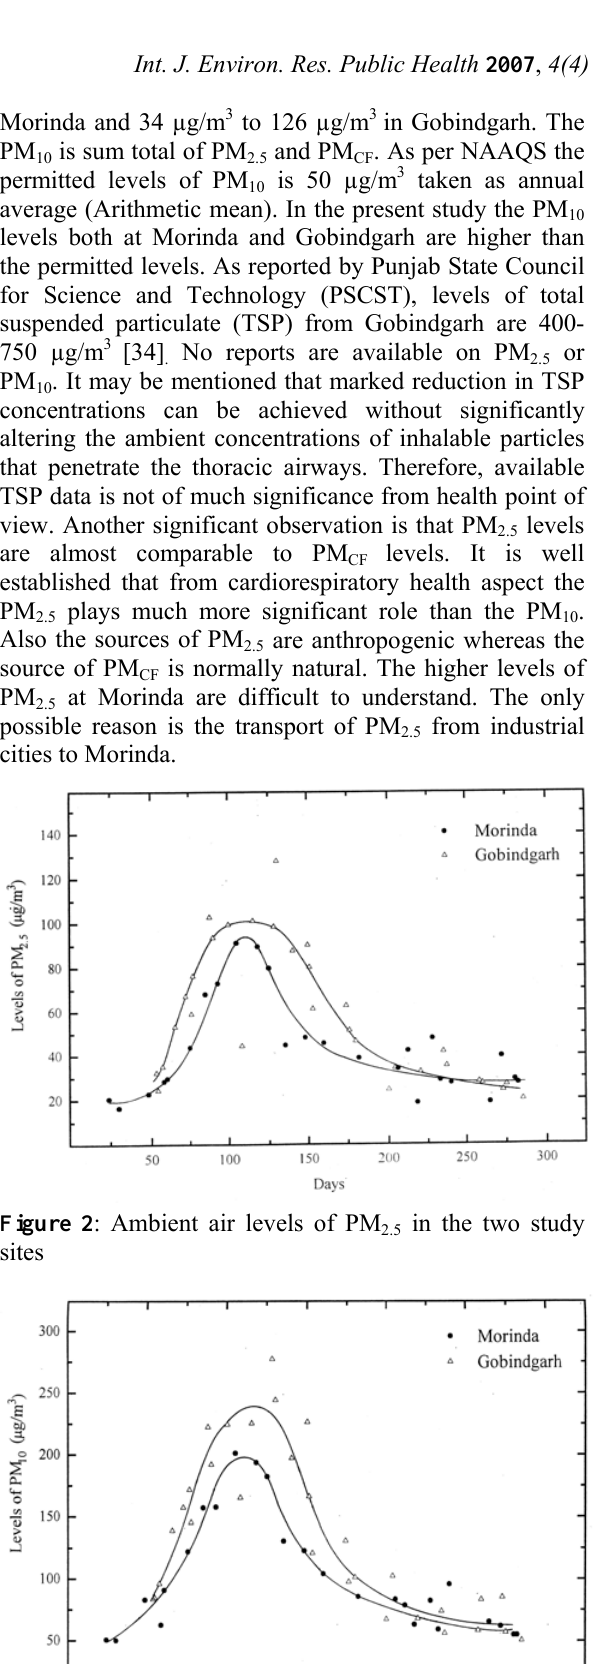
Figure 3 : Ambient air levels of PM